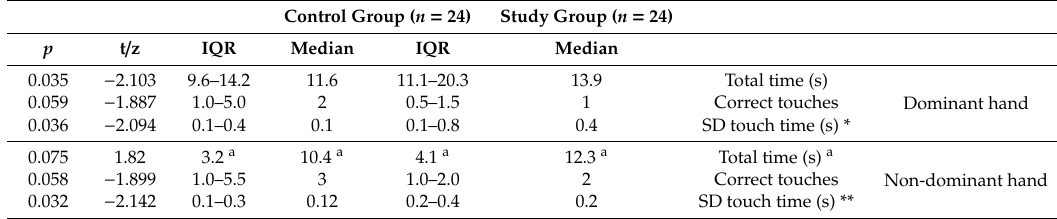
Table 3. Median and Inter-Quartile Range (IQR) of the Computerized Thumb-Finger Test scores. Control Group ( n = 24) Study Group ( n = 24)